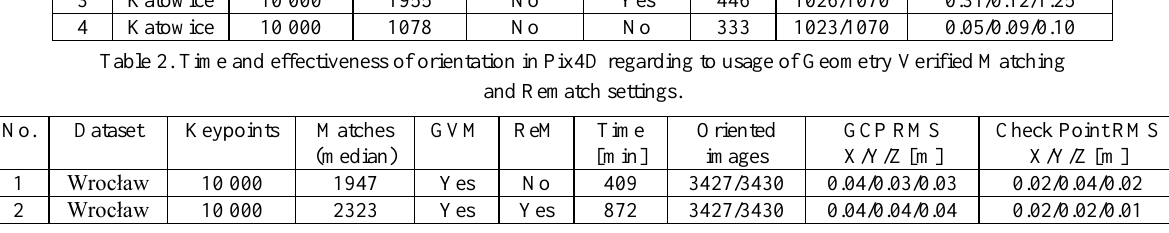
Table 3. Time and effectiveness of orientation in Pix4D regarding to usage of Rematch